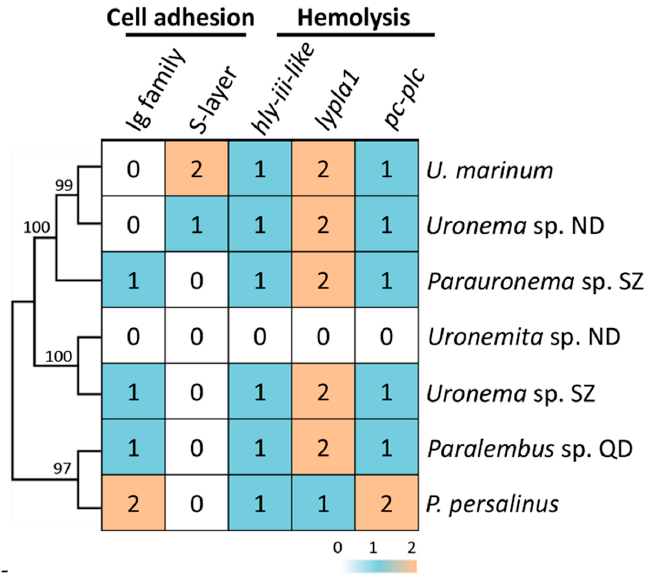
Figure 4. Distribution of hemolysis-related genes in seven scuticociliates. Numbers indicate the number of homologs identified in each species. The functional category was assigned as described in our previous study [7].